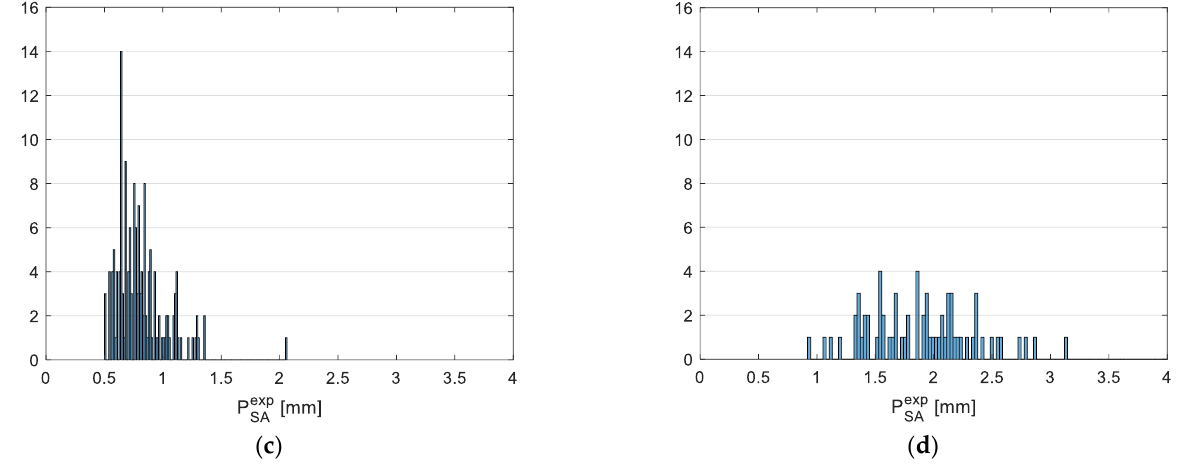
Figure 11. Distribution of P i characteristics over the whole analyzed sample and for all the granulometry classes considered: G1 long axis ( a ), G2 long axis ( b ), G1 short axis ( c ) and G2 short axis ( d ).